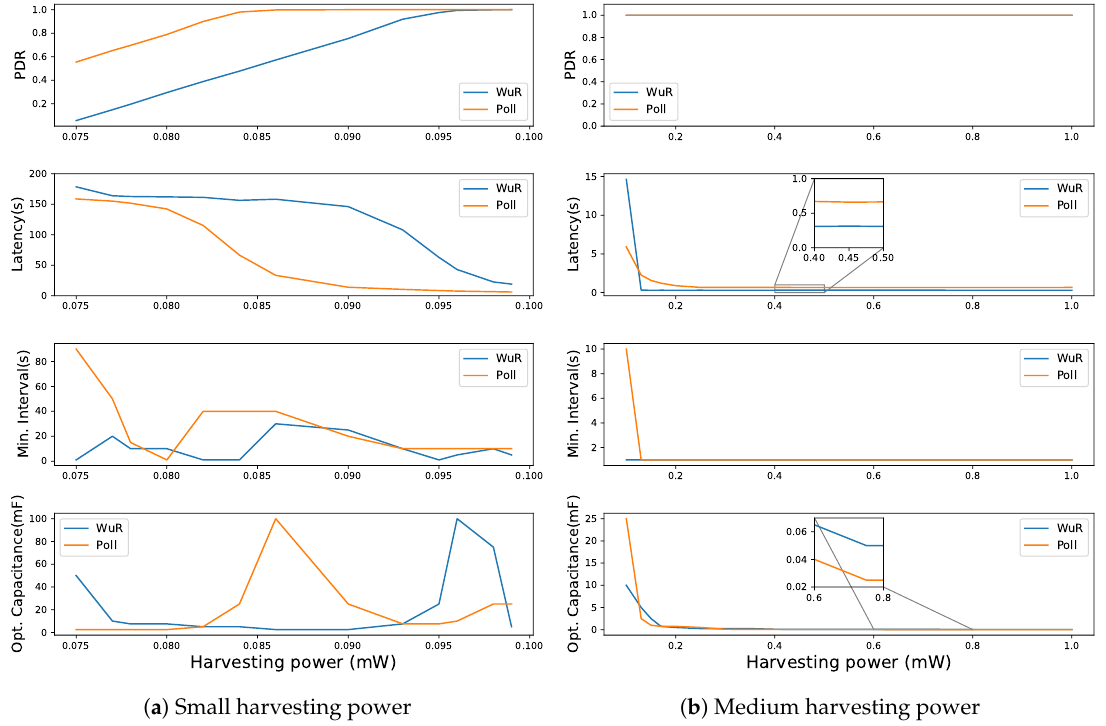
Figure 11. Comparing WuR-based and direct poll-based communication schemes for a Poisson packet arrival rate = 10